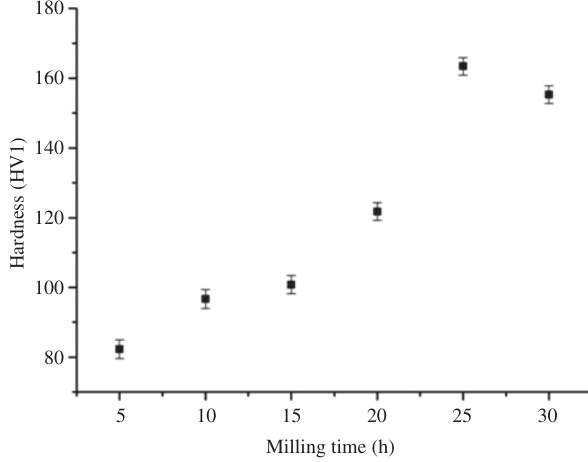
Figure 6 Influence of milling time on macro hardness values of Cu- 7vol.%ZrB alloy compacts. 2